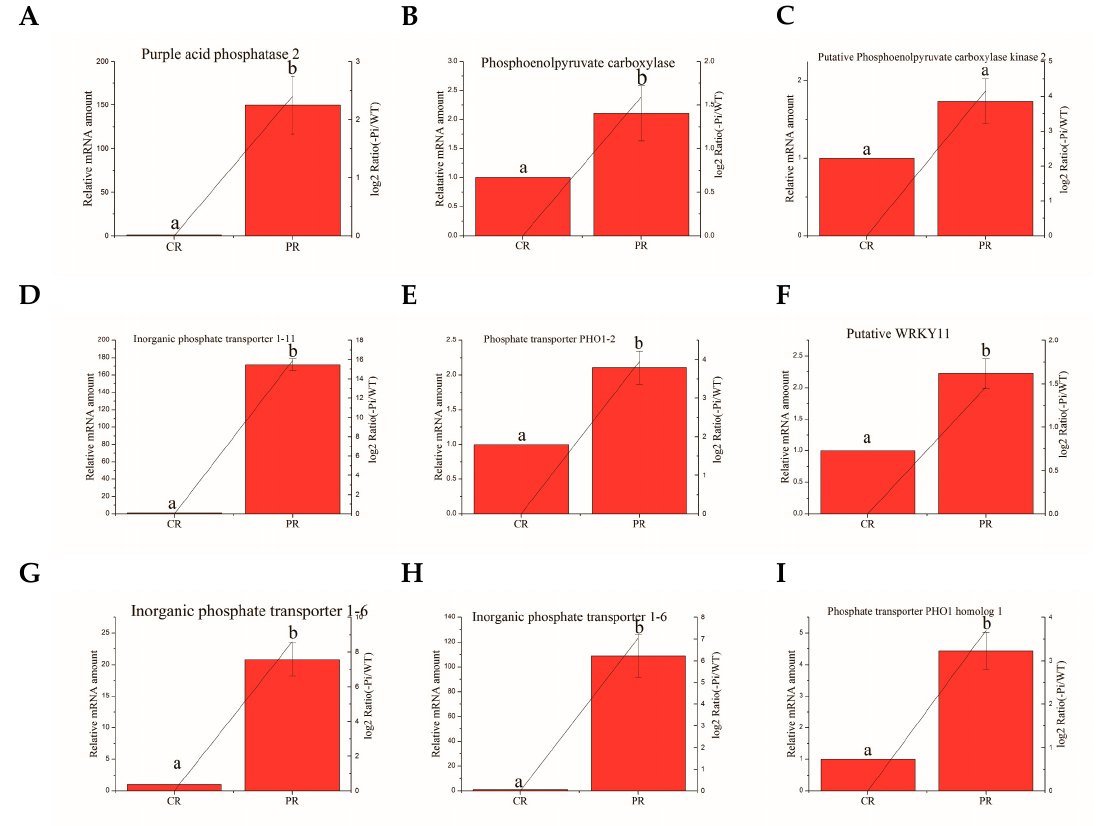
Figure 5. Relative expression of Pi deficit-induced genes in roots in WT and − Pi treatment was determined by quantitative RT-PCR analyses. Expression was normalized to that of actin . The transcript levels from the WT sample were set to 1. The red columns represent the expression levels determined by qRT-PCR (left axis), while the lines represent the gene expression levels determined by RNA-seq (right axis). The transcript abundances of genes encoding purple acid phosphatase 2 protein ( A ); hosphoenolpyruvate carboxylase ( B ); putative phosphoenolpyruvate carboxylase kinase 2 ( C ); inorganic phosphate transporter 1–11 ( D ); phosphate transporter PHO1–2 ( E ); putative WRKY11 ( F ), inorganic phosphate transporter 1–6 ( G , H ), and phosphate transporter PHO1 homolog 1 ( I ) were determined and compared across the time course of phosphorus deficit stress. Data represent means ± SD of three replicates ( n = 3). Different lowercase letters above the columns indicate a significant difference at p ≤ 0.05 between the columns by T test using SPSS statistical software. Data in columns with the same letters showed no significant difference ( p > 0.05).